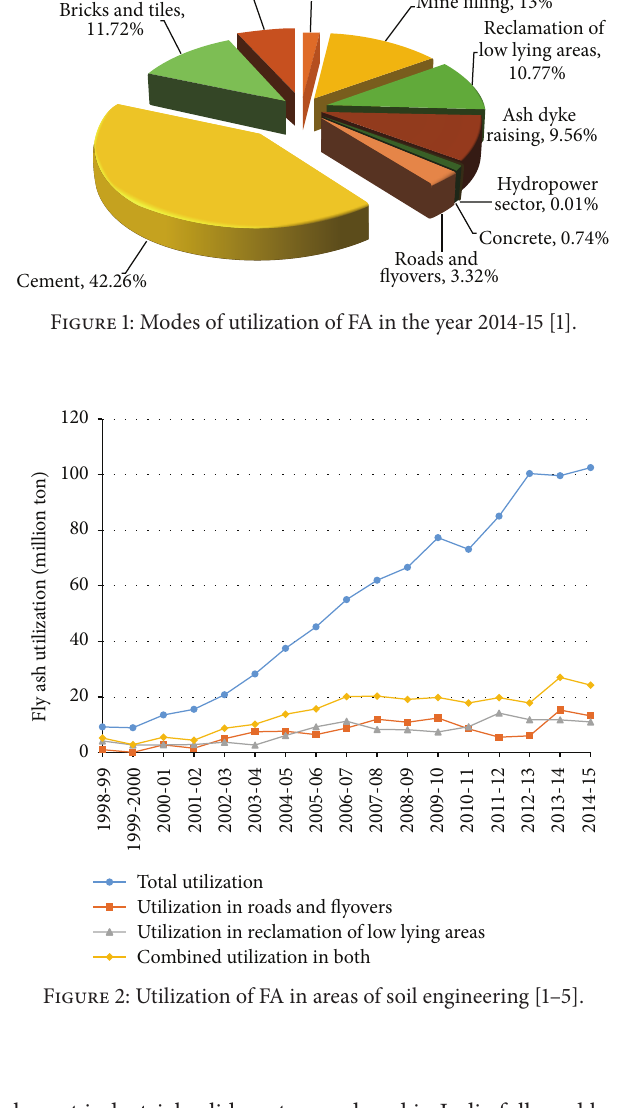
Table 1: Major industrial solid wastes generated in